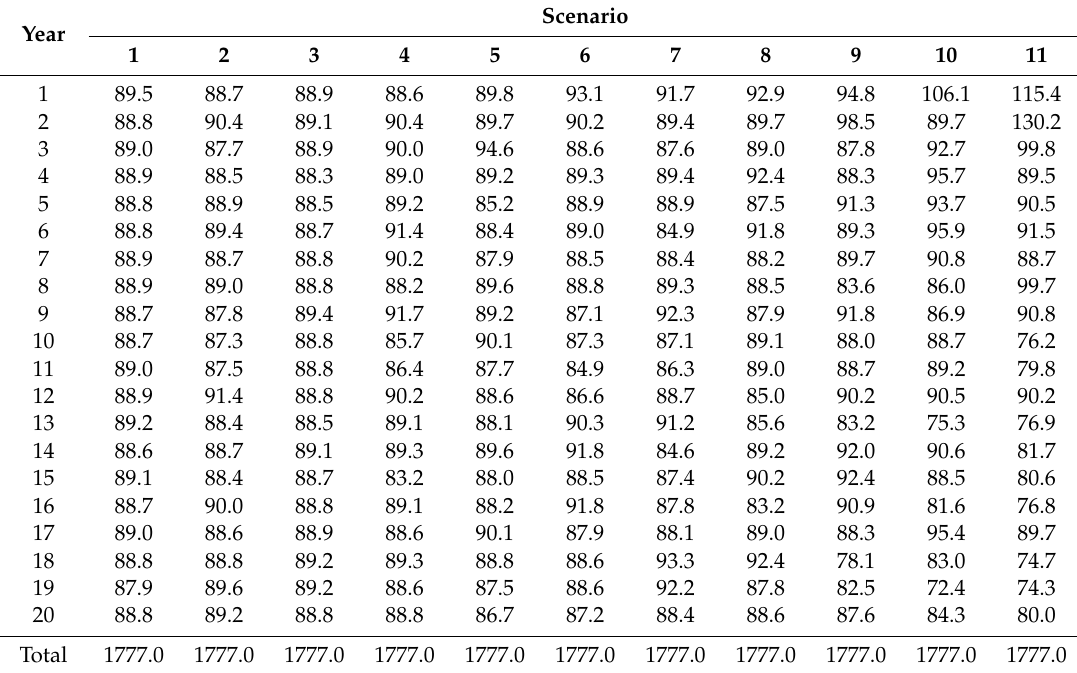
Table 5. Area (ha) scheduled for regeneration for all scenarios when using the regeneration model.